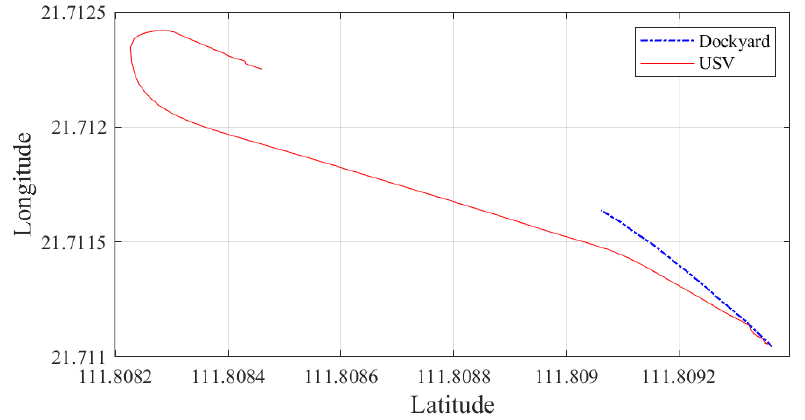
Figure 17. The actual automatic docking